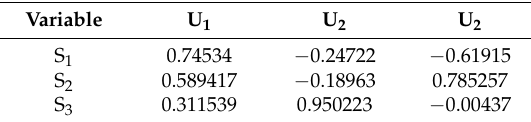
Table 3. Matrix of component score